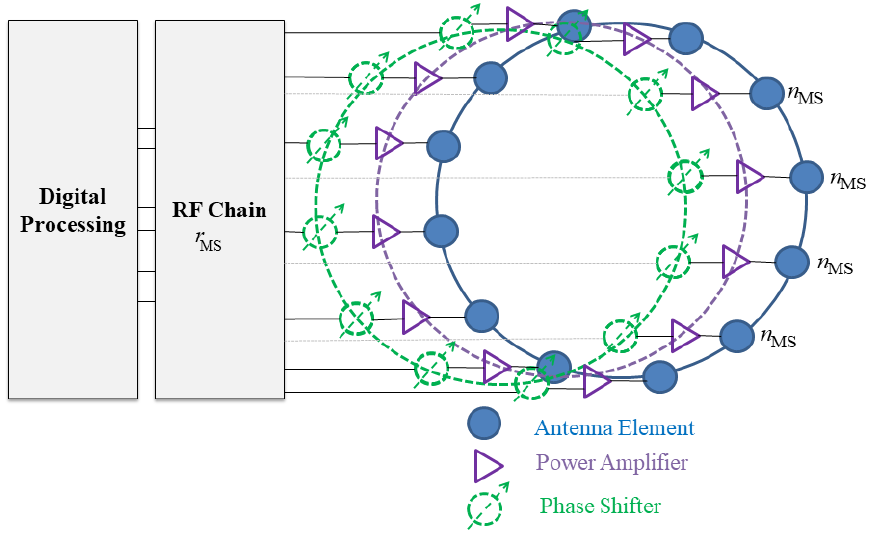
Figure 1. Analog beamformer at the MS.